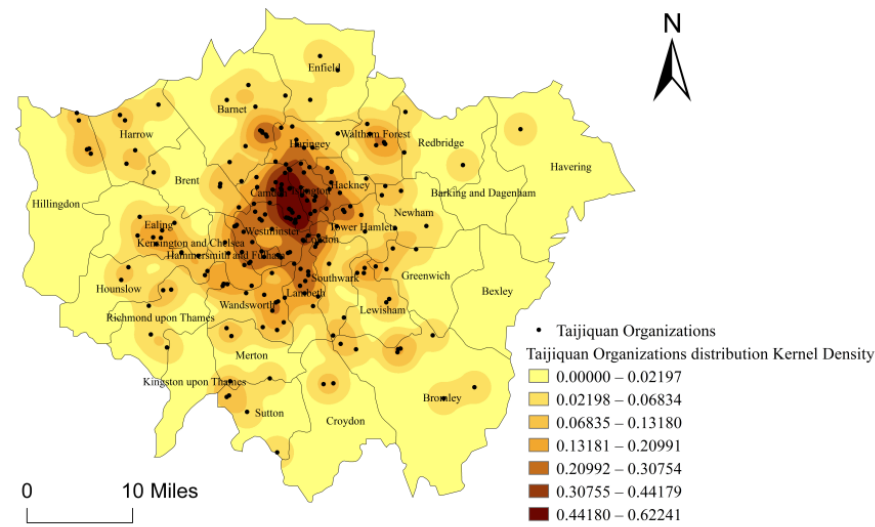
Figure 2. Kernel Density Map for the Distribution of Taijiquan Organizations in London.